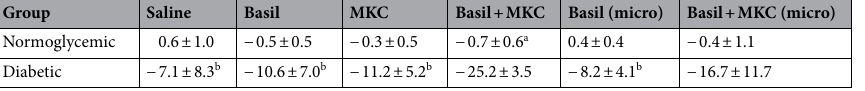
Table 2. Blood glucose level change in normoglycemic and diabetic animals after seven days of treatment. a p < 0.05 in relation to the group treated with saline. b p < 0.05 in relation to the group treated with basil + MKC.